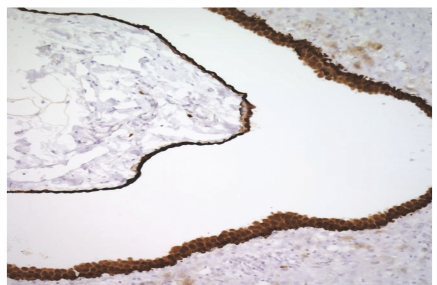
Figure 3: Calretinin positive cells lining the cyst wall.